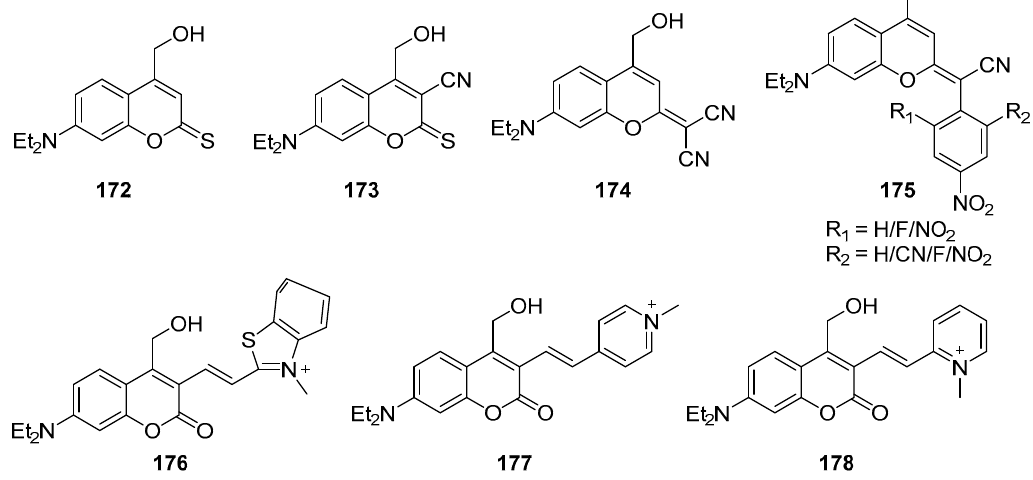
Figure 58. Structure of several coumarin photocleavable protecting groups.